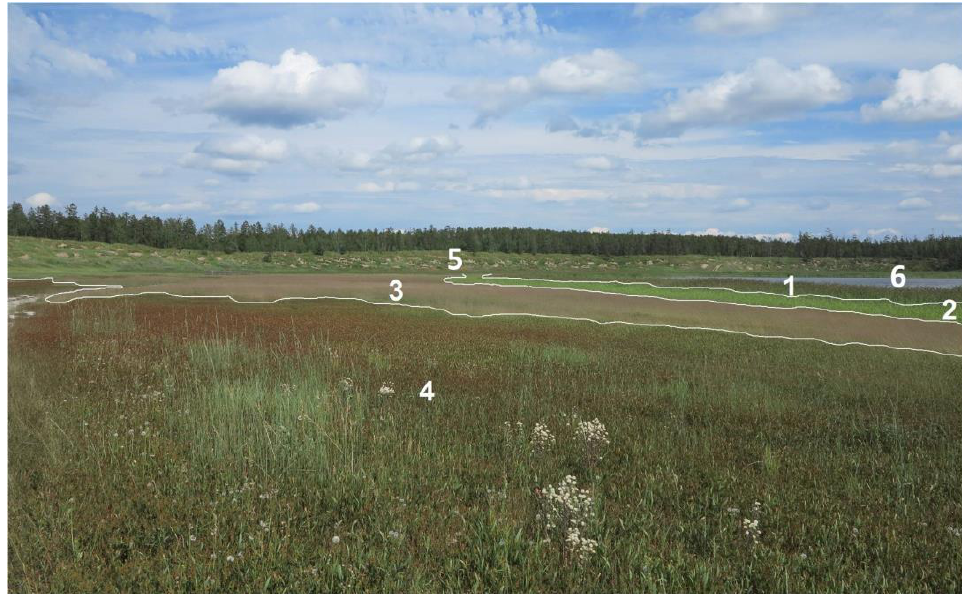
Figure 1. Spatial structure of a typical alas in Central Yakutia: 1 — belt of coastal aquatic vegetation; 2 — belt of wet meadow; 3 — belt of normal meadow; 4 — belt of steppe meadow; 5 — steppes on the southern exposure slope with baidzherakhs; 6 — lake.